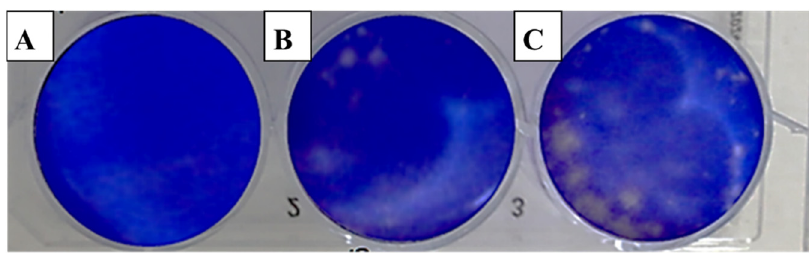
Figure 2. Effect of clove essential oil on plaque formation by hepatitis A virus (HAV) in cell culture using the plaque reduction assay: ( A ) Vero cells (control); ( B ) Vero cells infected with HAV and treated with oil; ( C ) Vero cells infected with HAV (infection control).